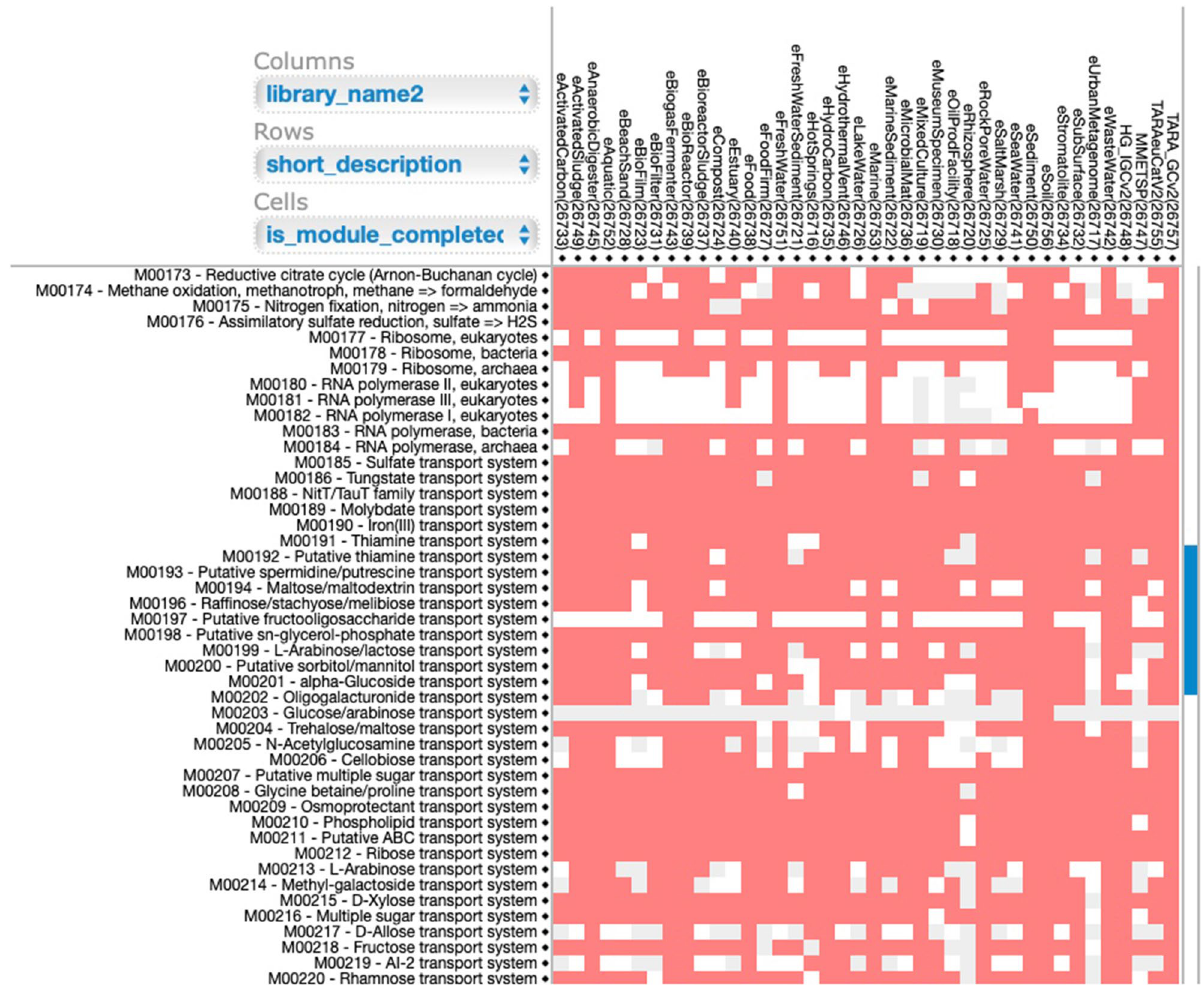
Figure 7. An interactive heatmap showing antibiotics resistance genes (ARGs) as complete (red color), incomplete (grey color) or not detected (white color) modules from KEGG KO pathways. A link to this interactive heatmap is available at https:// bit. ly/ 2AHyl wX, see Supplementary Video SV5 on how to reproduce